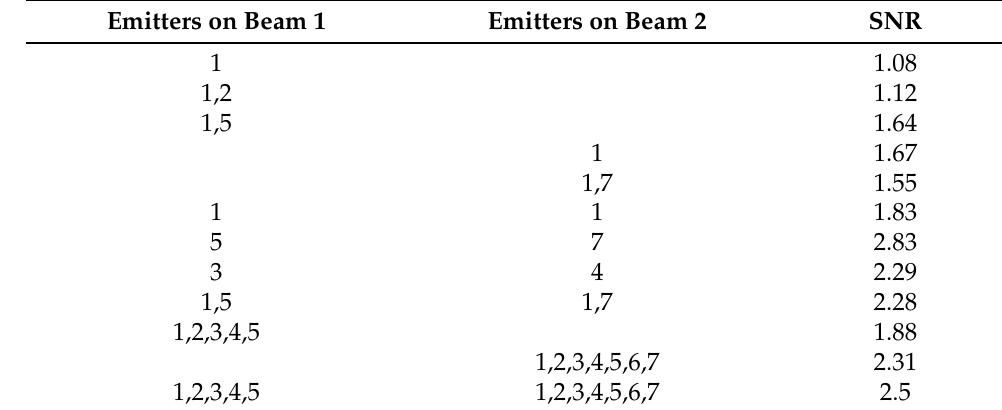
Table 1. The SNR for some combinations of emitters on Beam 1 and Beam 2 and for total number of 28 k time steps.